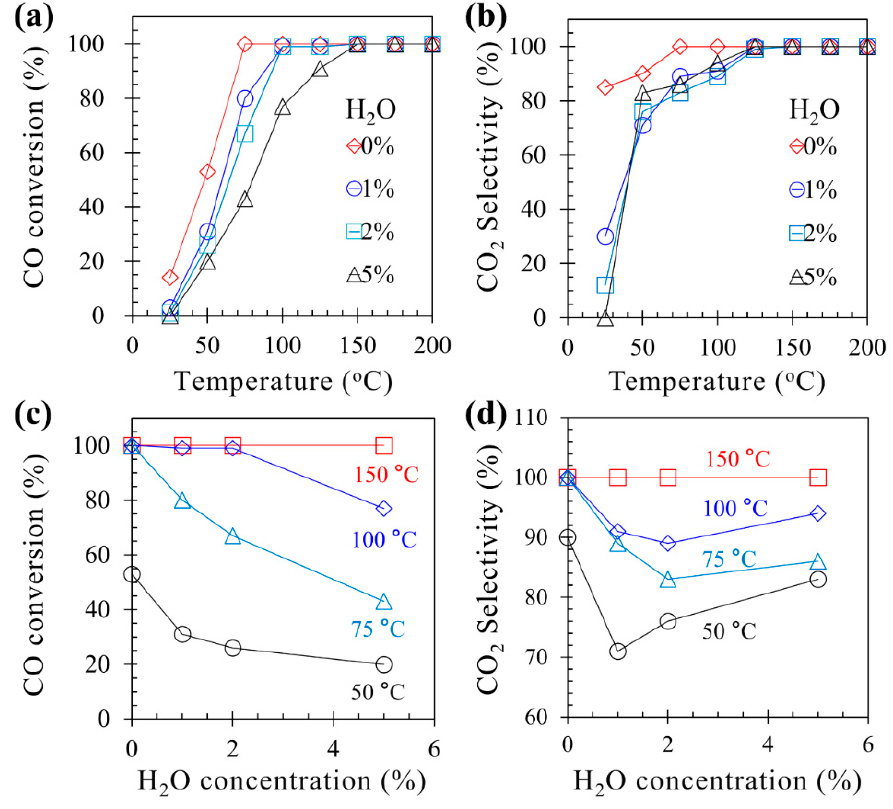
Figure 2. In fl uence of H 2 O on CO conversion ( a , c ) and CO 2 selectivity ( b , d ).